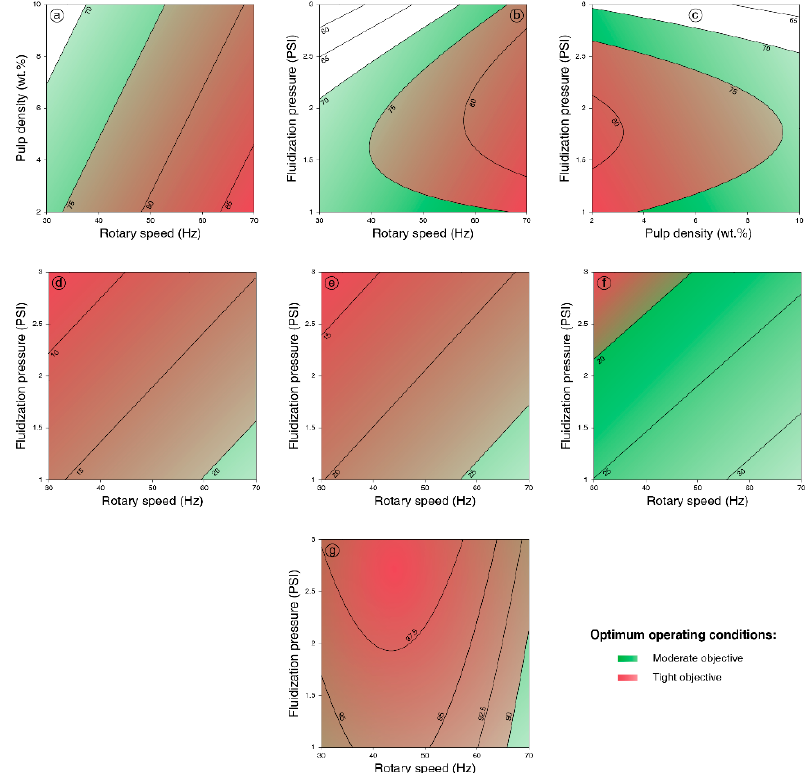
Figure 5 . 2-D contour plots for WO 3 recovery ( a – c ), K 2 O recovery ( d ), P 2 O 5 recovery ( e ), Fe 2 O 3 recovery ( f ), and desliming efficiency ( g ) for the Falcon SB models as a function of the operating parameters. The green and the red zones correspond to values which satisfy respectively the moderate and the tight performance objectives defined in Table 3.